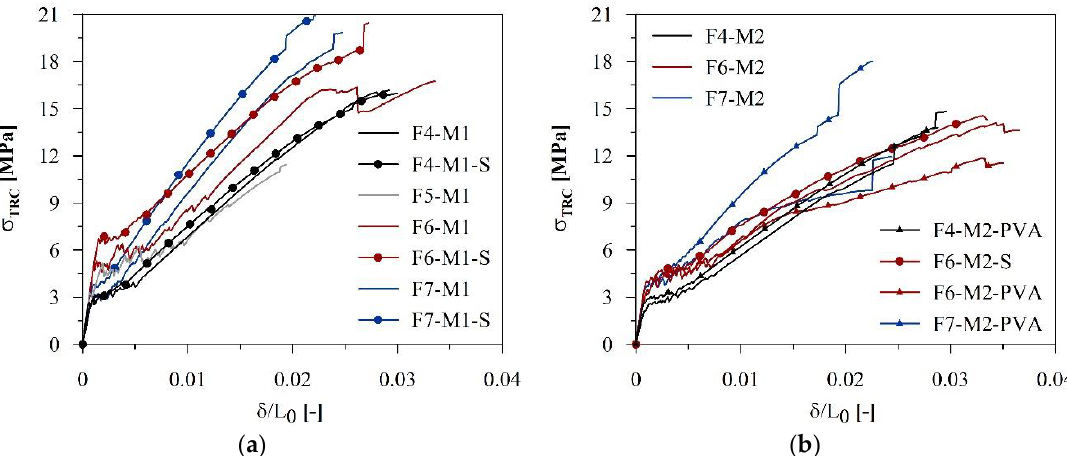
Figure 6. Average tensile response in terms of nominal stress vs. normalised displacement for M1-based ( a ) and M2-based ( b ) composites reinforced with Fabrics F4–F7 (warp direction).